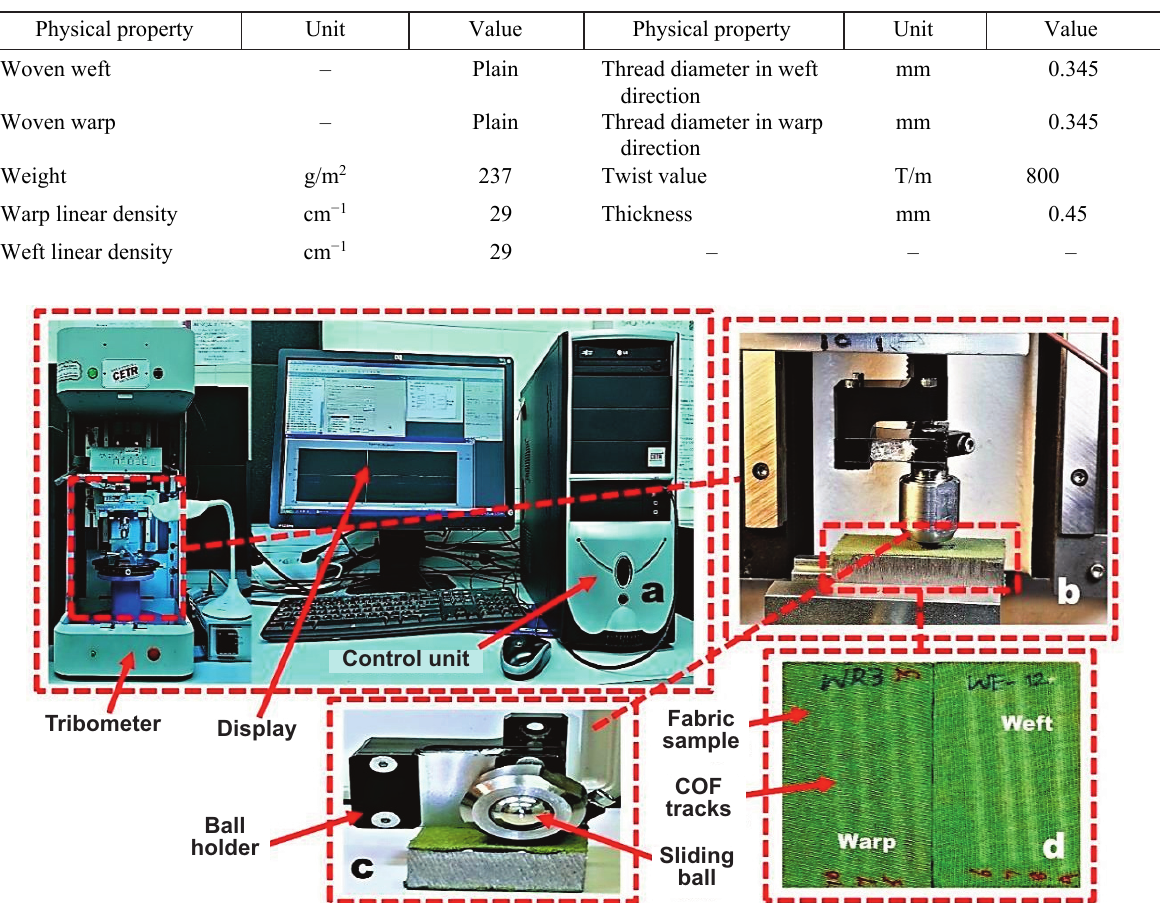
Fig 1 Experimental setup: (a) tribometer equipment (b) experiment demonstration (c) ball slider and (d) fabric Fig. 1. Experimental setup: (a) tribometer equipment, (b) experiment demonstration, (c) ball slider and (d) fabric sample after tribology